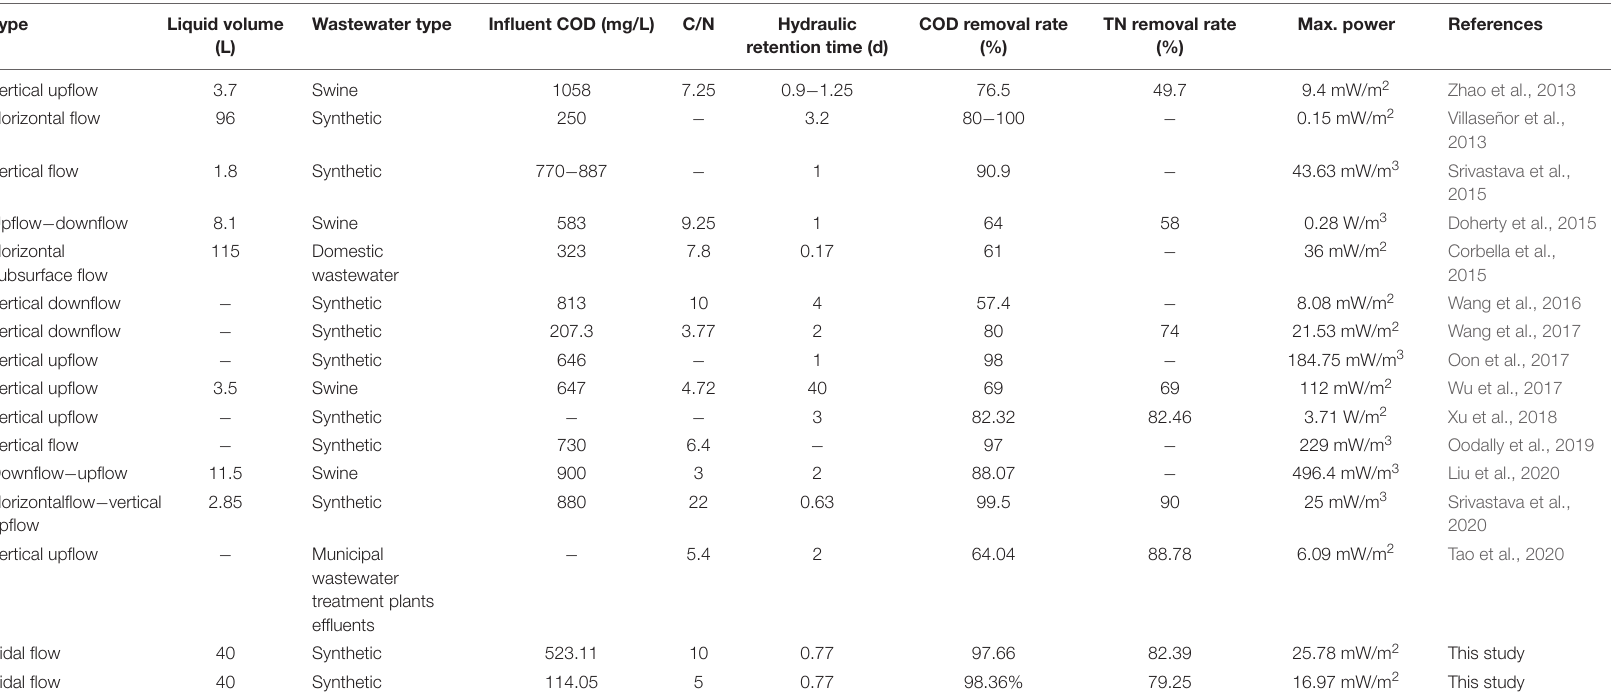
TABLE 2 | Operating conditions and performance comparison of TFCW-MFC and other